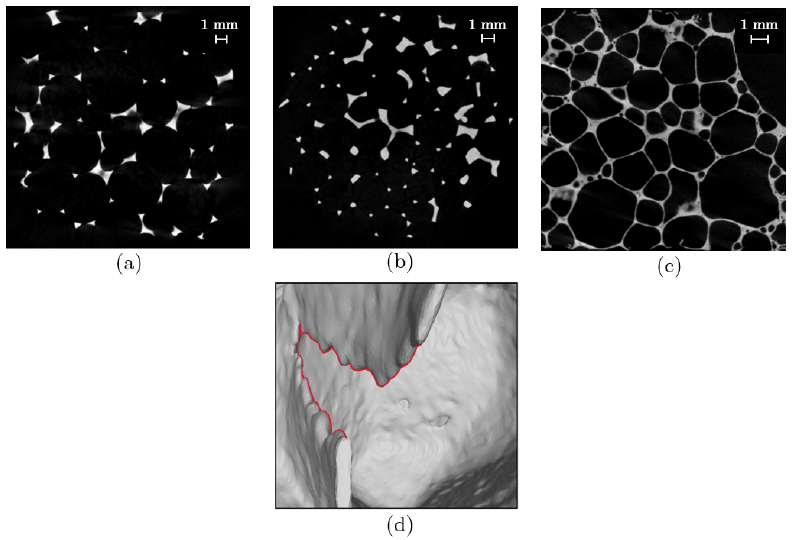
Figure 1. 2D slices of the ( a ) cubic open-cell foam, ( b ) cylindrical open-cell foam and ( c ) closed-cell foam specimens. ( d ) Section of crack identified in the closed-cell foam